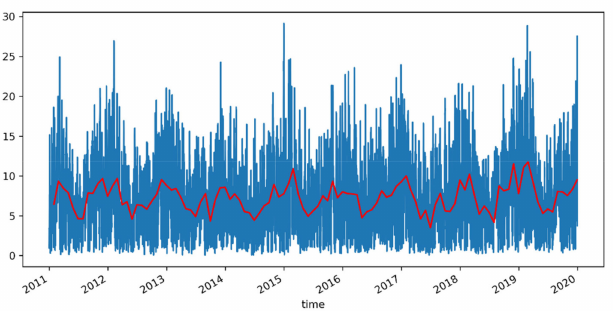
Figure 4. 6-hourly time series (blue line) and mean-monthly time-series (red line) of wind speed at hub height in the Lemnos Plateau (grid point 46).